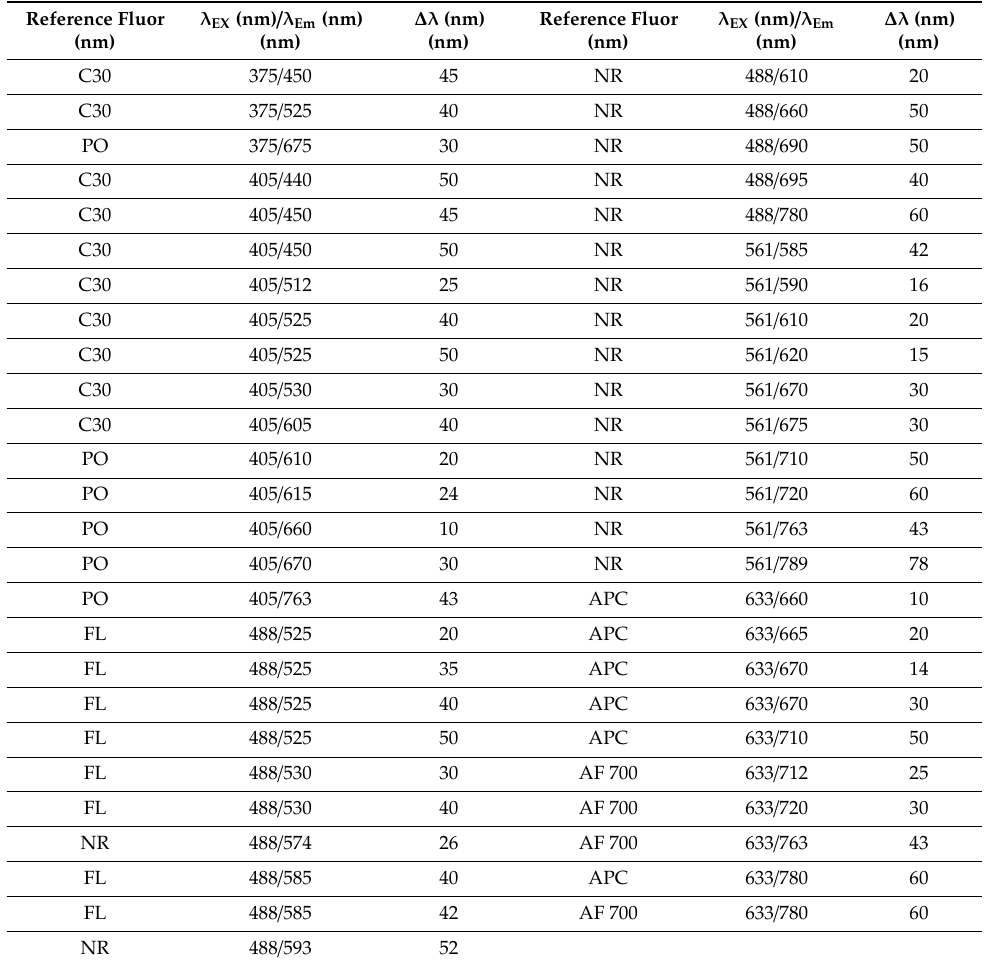
Table 2. NIST Assigned Fluorescence Channels with specified reference fluorophore (fluor), excitation wavelength ( λ EX ), center wavelength of the emission range ( λ Em ) and bandwidth of the